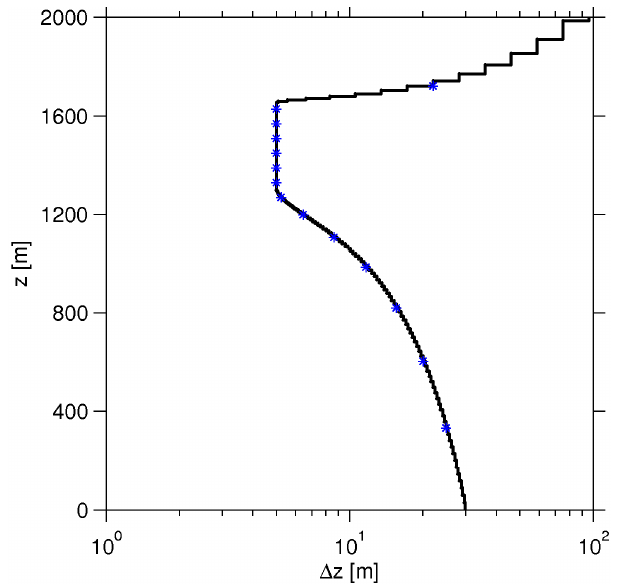
Fig. 1. Vertical model grid plotted as 1z vs. z . Blue asterisks are model grid plotted as ∆ z vs. z . Blue asterisks are plotted every 12 model levels. Fig. 1. Vertical plotted every 12 model levels.